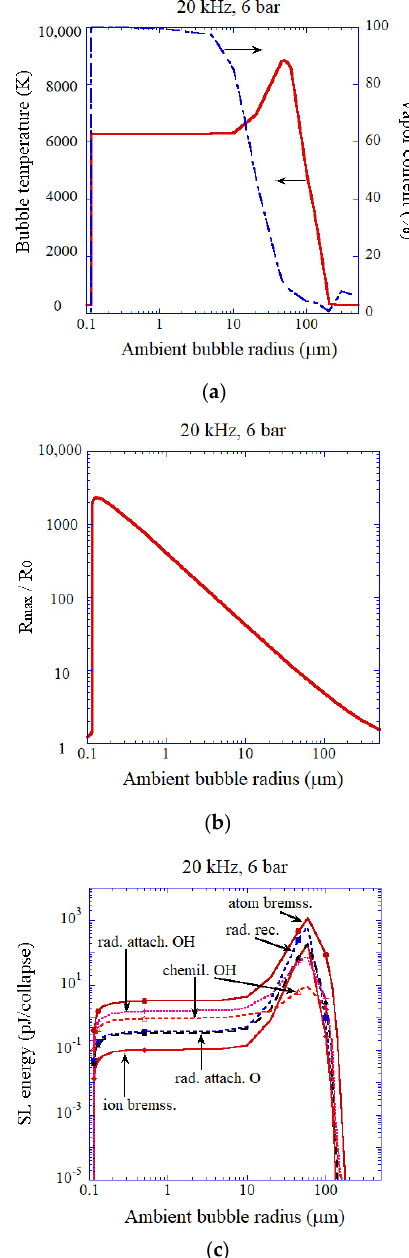
Figure 17. The calculated results for an air bubble as a function of ambient bubble radius at 20 kHz and 6 bar in ultrasonic frequency and acoustic amplitude, respectively [43]. The horizontal axis is in logarithmic scale. ( a ) The peak temperature (solid) and the molar fraction of water vapor (dash dot- ted) inside a bubble at the end of the bubble collapse. ( b ) The expansion ratio (R max /R 0 ). ( c ) The in- tensity of each emission process in SL. The vertical axis is in logarithmic scale. Copyright 2008, with the permission of AIP Publishing.